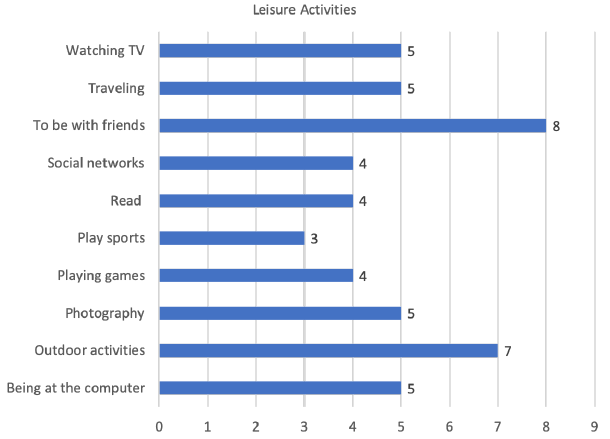
Figure 6. Participant answers to the question about leisure